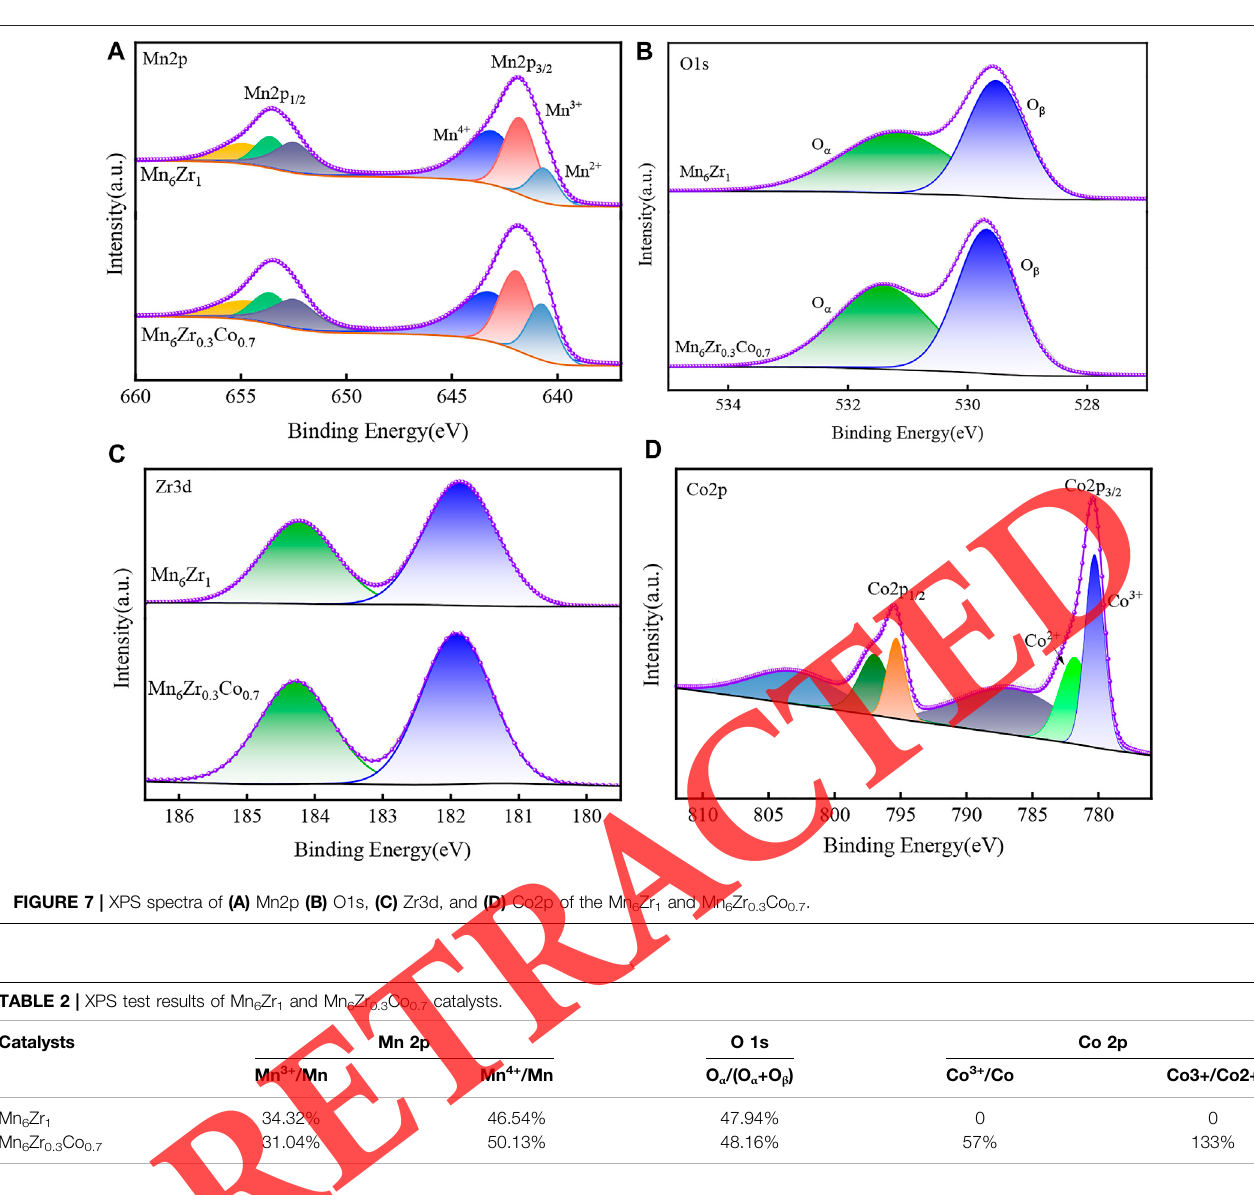
TABLE 2 | XPS test results of Mn 6 Zr 1 and Mn 6 Zr 0.3 Co 0.7 catalysts.